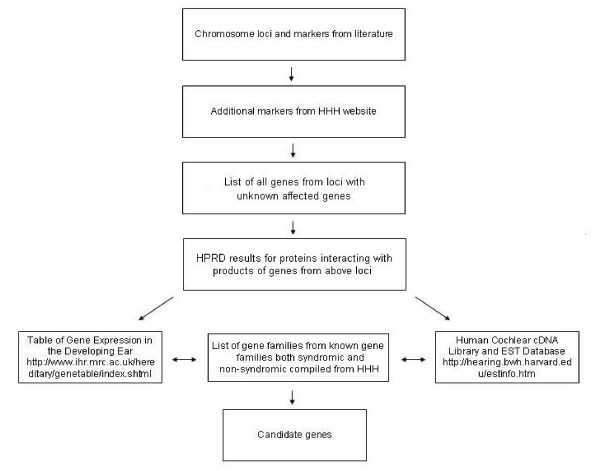
Schematic flow for information processing to predict candidate genes. The rectangles contain tasks that were processed in the sequence as indicated by arrows.